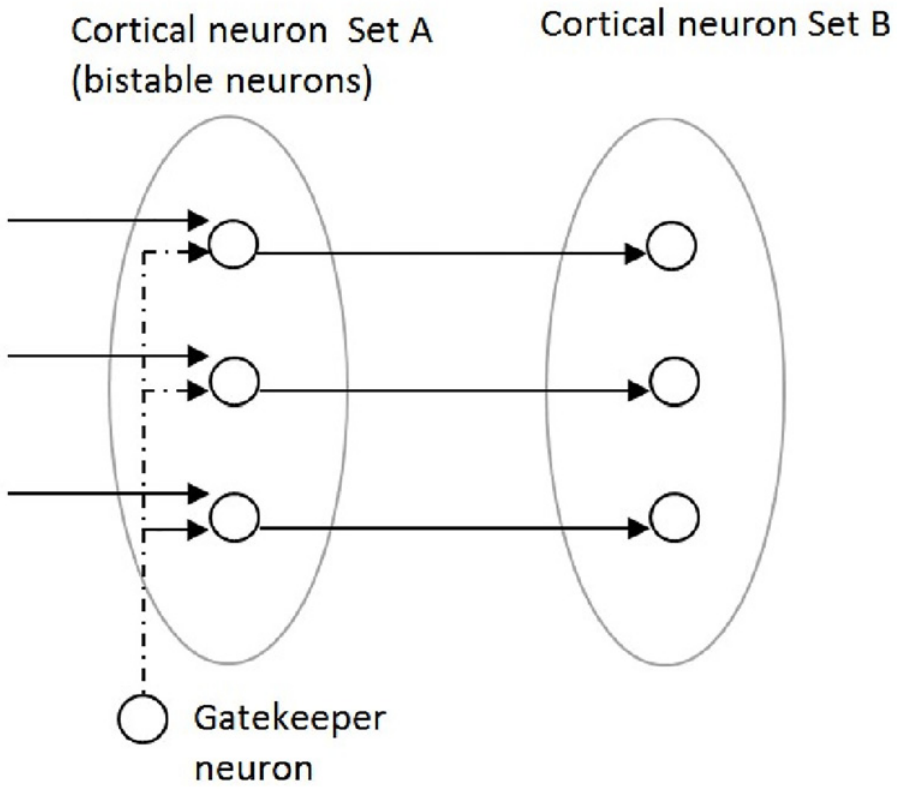
Fig 3. Type of neural gating mechanism used in the ANNABELL model. (adapted from Ref. [39]).